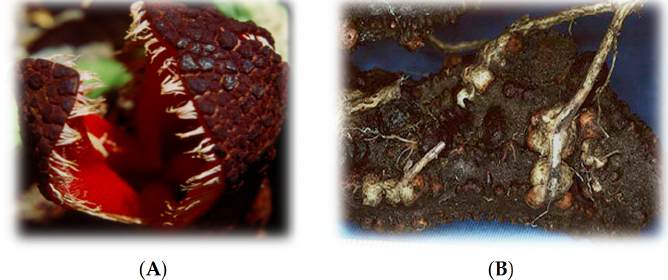
Figure 1. Hydnora africana plant parts; Source http://www.botany.org/Parasitic_Plants/. ( A ) The flower of Hydnora africana ; ( B ) The root of Hydnora africana used.